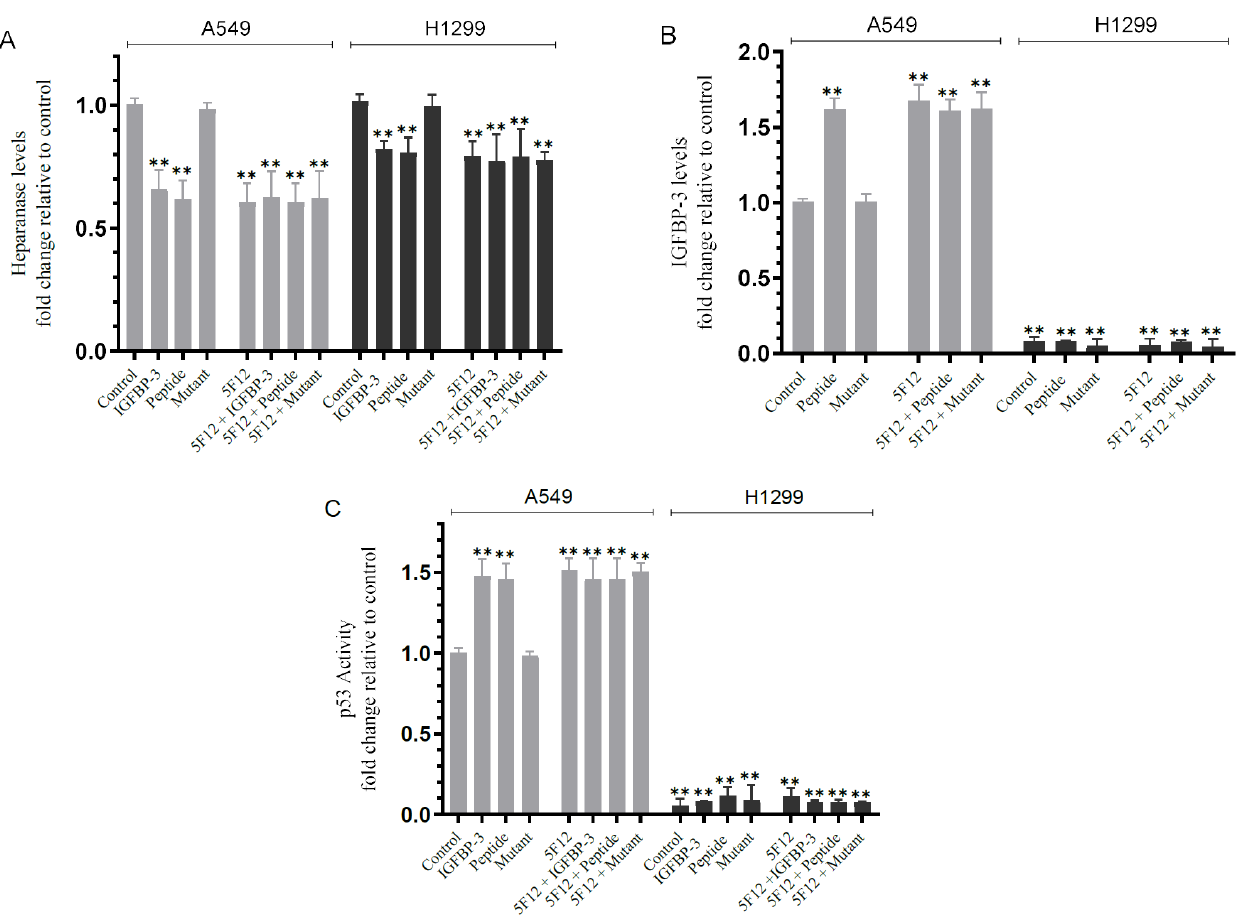
Figure 5. Blocking HA–CD44 signaling decreases the levels of heparanase in the media of both cell lines and increases p53 activity and the levels of IGFBP-3 in A549 cell media. Cells (0.2 × 10 5 ) were grown in 10% FBS-supplemented media for 24 h. The following day, the cell monolayers were incubated in serum-free media for 24 h, then treated as indicated for 72 h with 50 nM of IGFBP-3 protein/peptide/mutant, the CD44 antibody (5F12, 5 µg/mL) added either separately or 2h prior to addition of IGFBP-3/peptide/mutant, or in combination. The levels of heparanase ( A ) and IGFBP-3 ( B ) in the media, using the same amount of protein (3 µL of 600 µg/mL total protein), and the p53 activity ( C ) in cell lysates were measured as described in the Materials and Methods section. The graphs summarize the results expressed as means ± SD (n = 5) using the GraphPad 9.4.1 software. Fold change was calculated relative to the control of each cell line ( A ) or to the A549 control ( B , C ). Asterisks indicate a statistically significant difference from the corresponding negative control of each cell line, Mann–Whitney test. Statistical differences between different groups were analyzed by a non-parametric Kruskal–Wallis test. Absence of asterisks indicates no significance, ** p < 0.01.